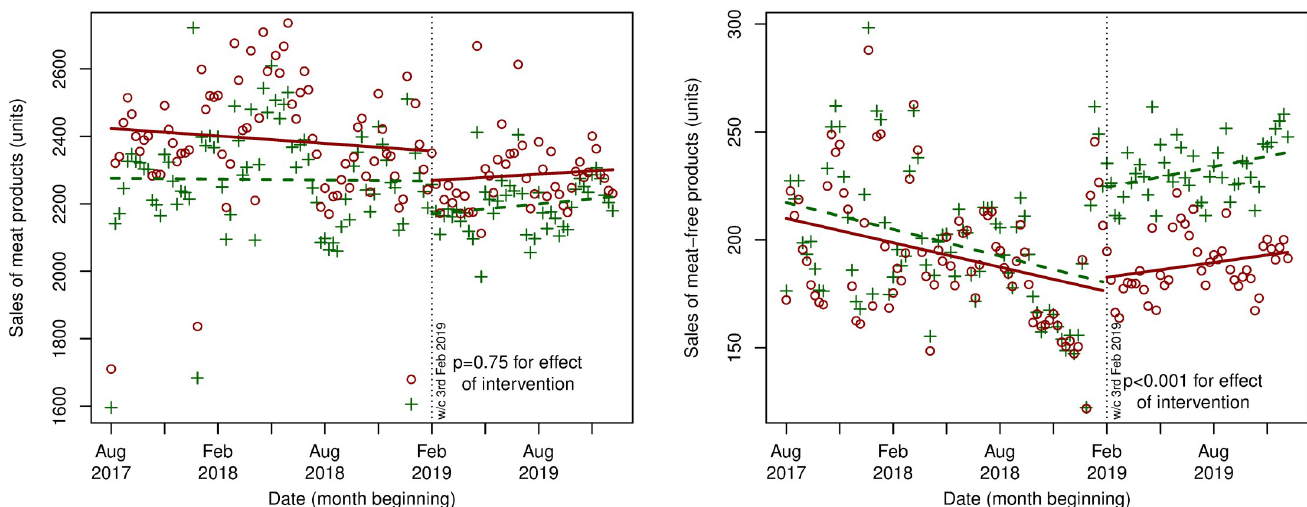
Fig 2. Interrupted time series analysis showing level and trend changes in sales (units) of meat and meat-free products before and after Phase I intervention (week commencing February 3, 2019) in intervention stores ( n = 20) and control stores ( n = 88). � Red dots denote control stores, and green crosses denote intervention stores.